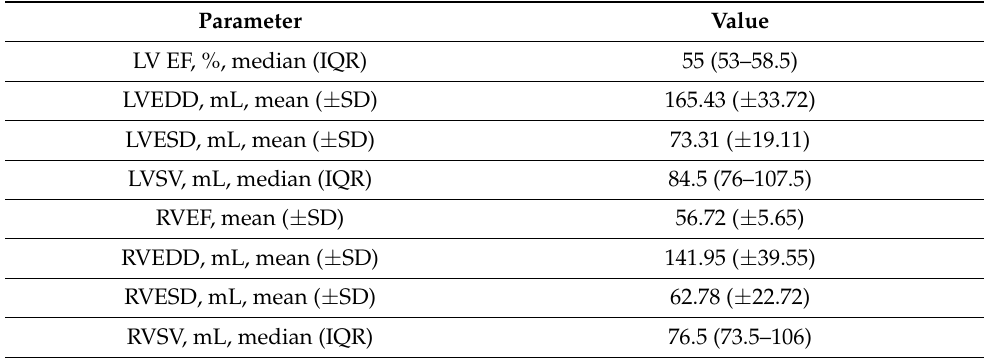
Table 2. Summary of the CMR parameters.